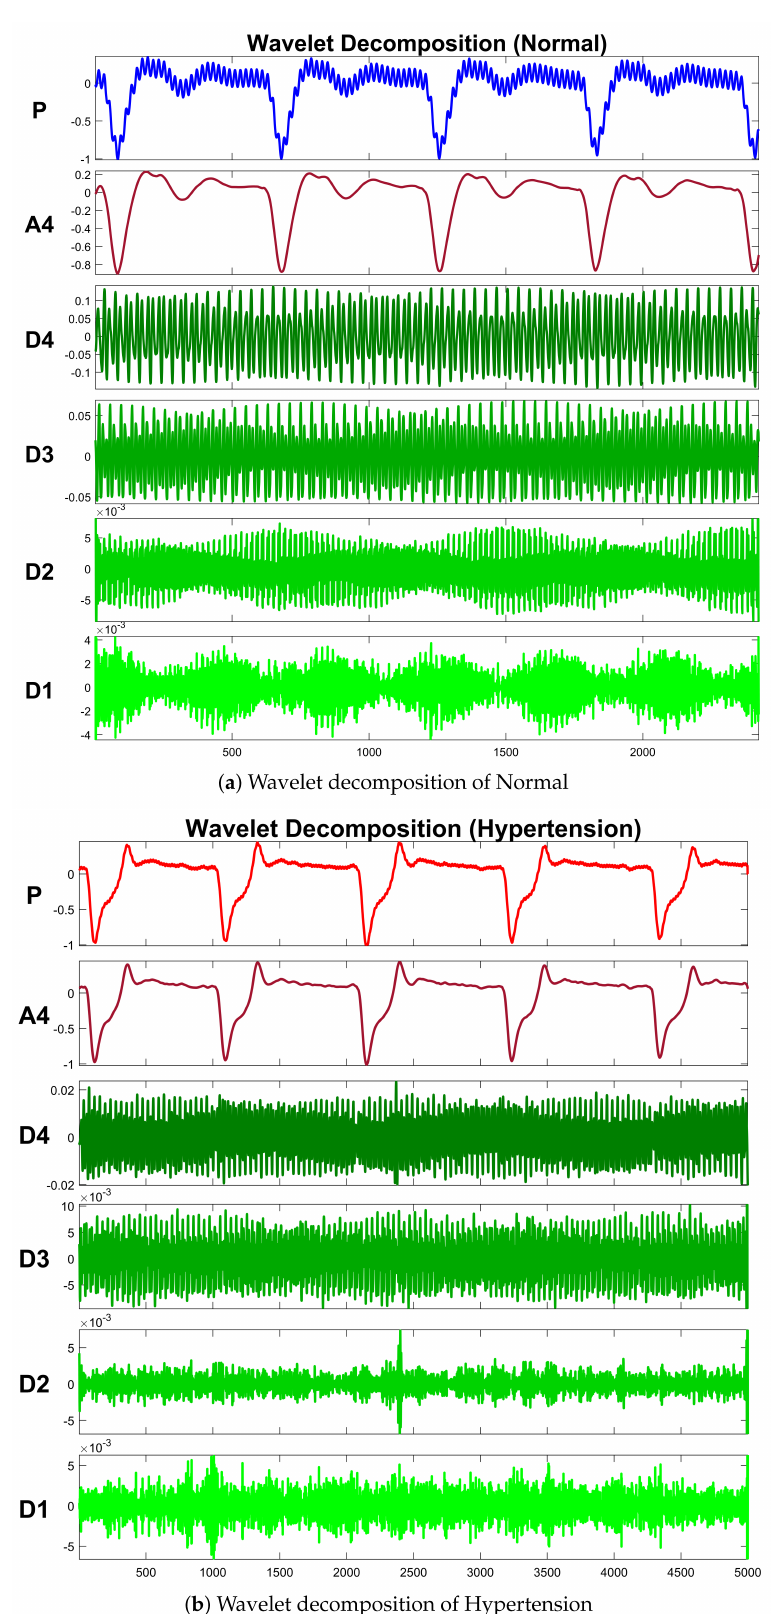
Figure 5. Wavelet decomposition of raw PuPG